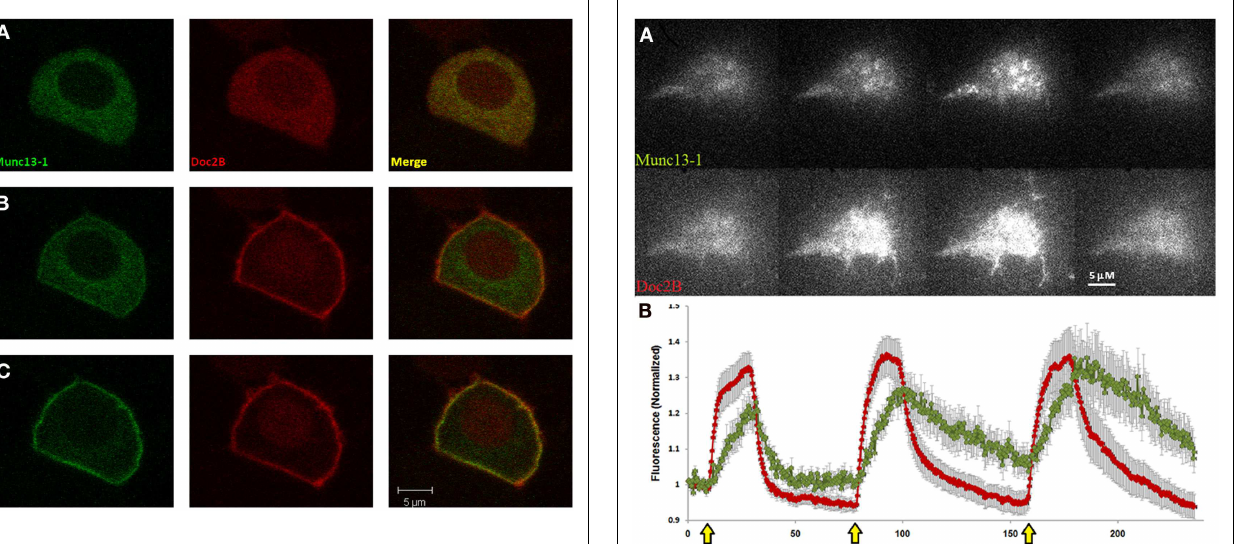
FIGURE 1 | Co-translocation of Doc2B wt and Munc13-1 wt . Confocal images of a PC12 cell co-expressing Munc13-1 wt -EGFP (left) and Doc2B wt -mRFP (middle). Merged images presented on the right. (A) At basal calcium both proteins have a cytoplasmic distribution. (B) At the initial phase of the calcium elevation (2–10s after KCl application), translocation of Doc2B occurs, but Munc13-1 is still mainly cytoplasmic. (C) Munc13-1 wt translocation is seen only at later stages of the experiment when Doc2B concentration on the membrane is higher (10–20s after KCl application).